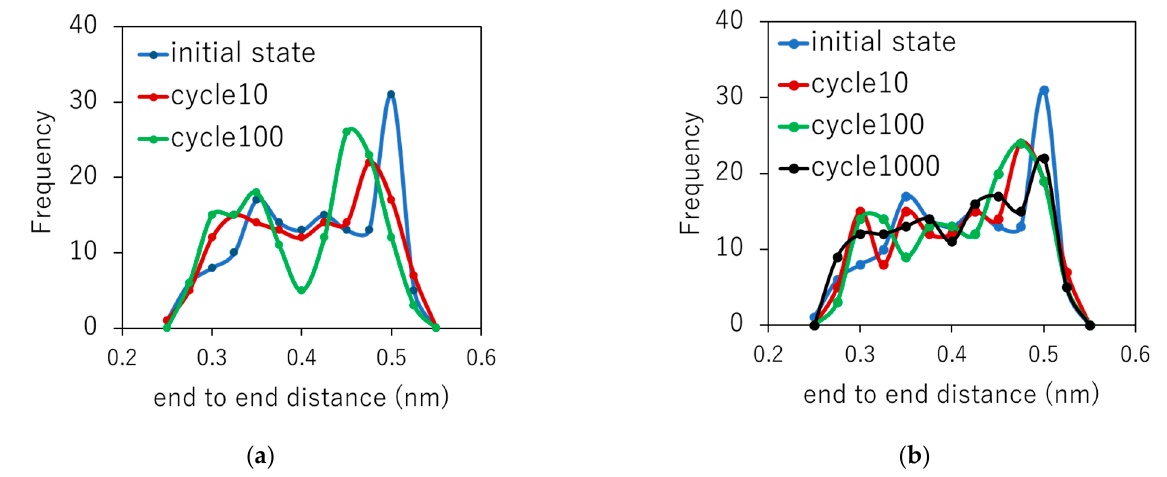
Figure 7. Frequency distribution of R for strain rates of ( a ) 5.0 × 10 8 /s and ( b ) 5.0 × 10 9 /s.